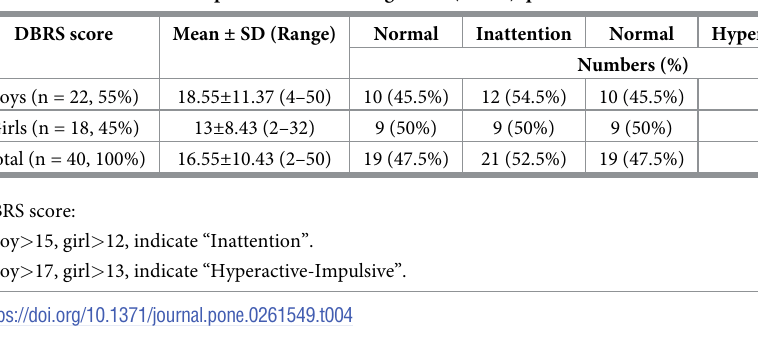
Table 4. Results of the Disruptive Behavior Rating Scales (DBRS) questionnaire.